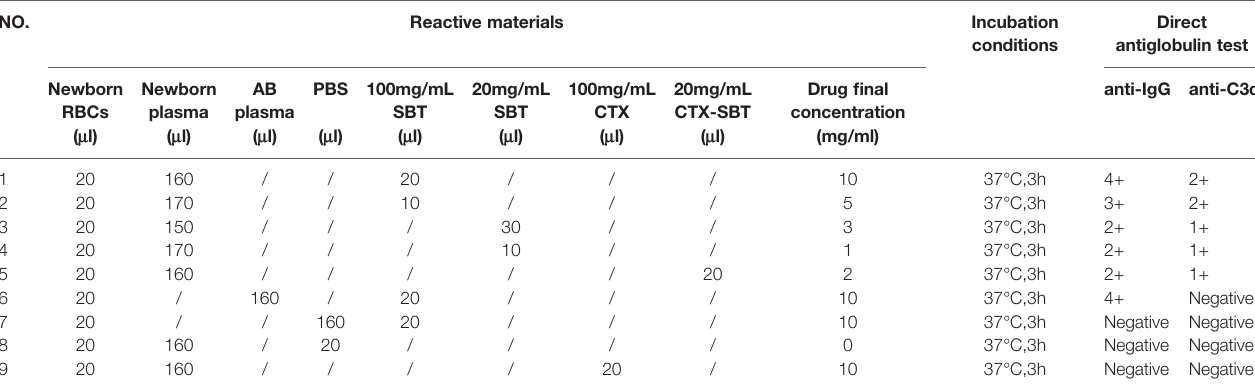
TABLE 2 | In vitro veri fi cation experiment of NIPA related to CTX versus SBT. NO. Reactive materials